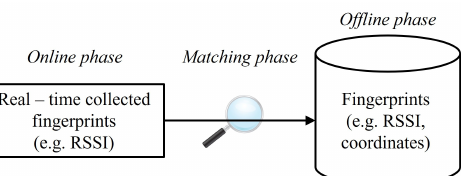
Figure 9. Fingerprinting localization technique, reproduced with permission from Khudhair, Wireless Indoor Localization Systems and Techniques: Survey and Comparative Study , published by